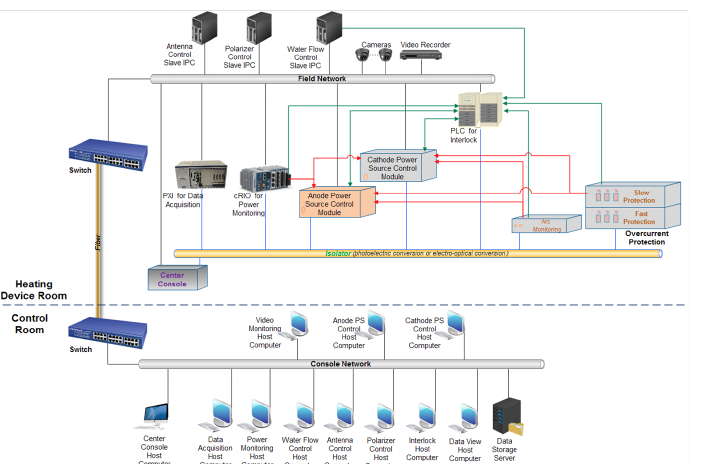
Fig. 4. The architecture of the control & interlock